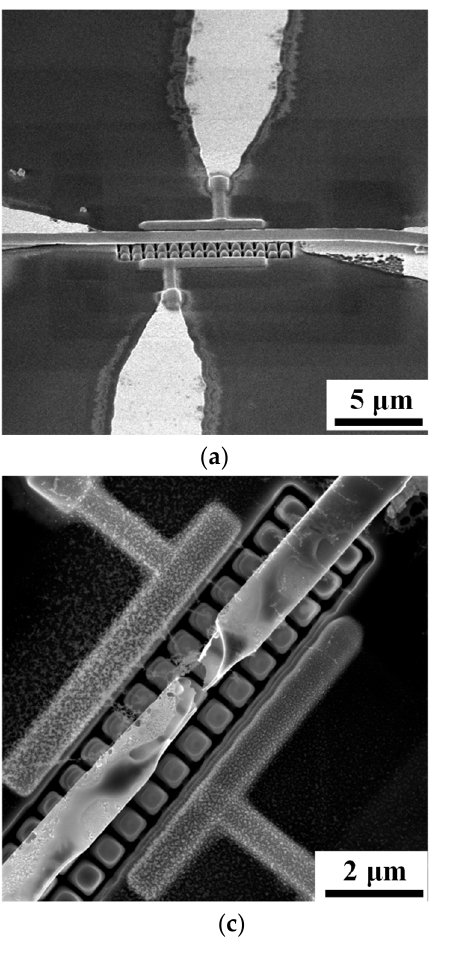
Figure A2. SEM images of an ionization gas detection device using a GaP nanoribbon and a nanoarray before (a,b) and after (c,d) gas discharge: ( a ) a single Gap nanoribbon is placed above the hybrid nanoneedles, which is detailed in ( b ), the metallic nanodot sitting on the top of each nanoneedle; ( c ) the breakdown of GaP nanoribbon and ( d ) the morphology characteristics of the fracture, where the products bridge the nanoribbon and nanodot